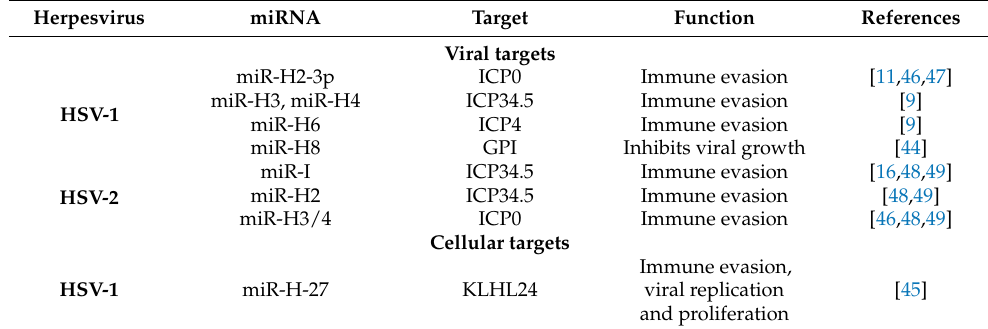
Table 2. Potential cellular and viral targets of HSV miRNAs 2